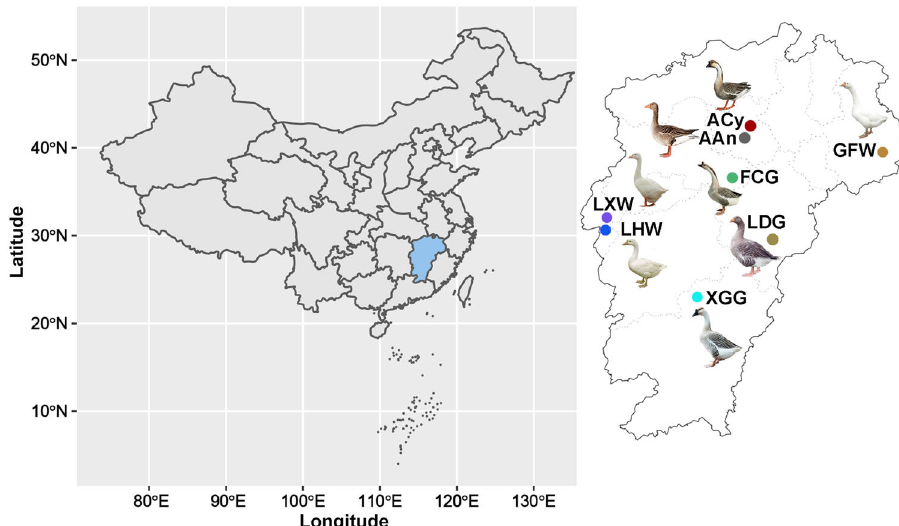
Fig. 1 Morphology and geographical distribution of domestic geese breeds and their ancestors. Circles arecolored accordingtopopulation.Domesticgeese breeds including XGG(Xingguo gray goose),LXW (Lingxian whitegoose),LHW (Lianhua whitegoose),FCG(Fengcheng gray goose),andGFW(Guangfeng white goose) in China and LDG (Landaise goose) in Europe. Ancestors include ACy (swan goose, Anser cygnoides ) and AAn (greylag goose, Anser anser